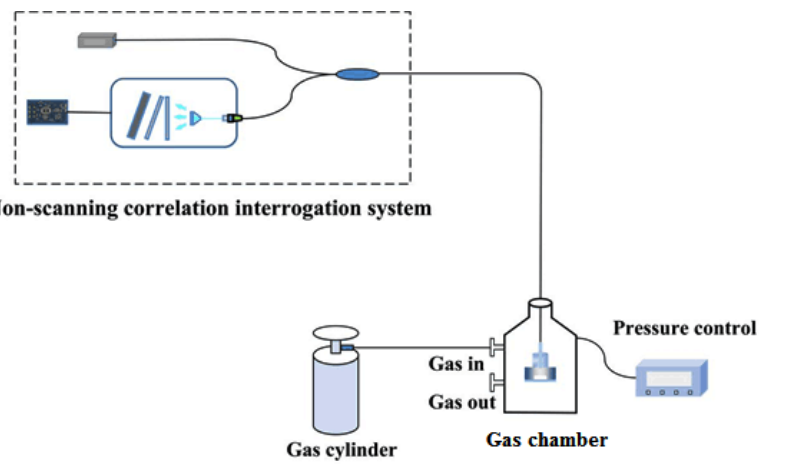
Figure 7. Cavity length interrogation of a compound fiber FP pressure sensor under a pressure testing experiment.